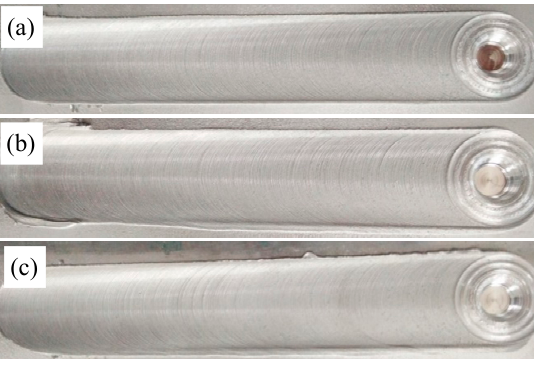
Figure 4. The weld surfaces of the friction stir welds (FSWs) under different states: ( a ) T1; ( b ) T4; ( c ) T6.